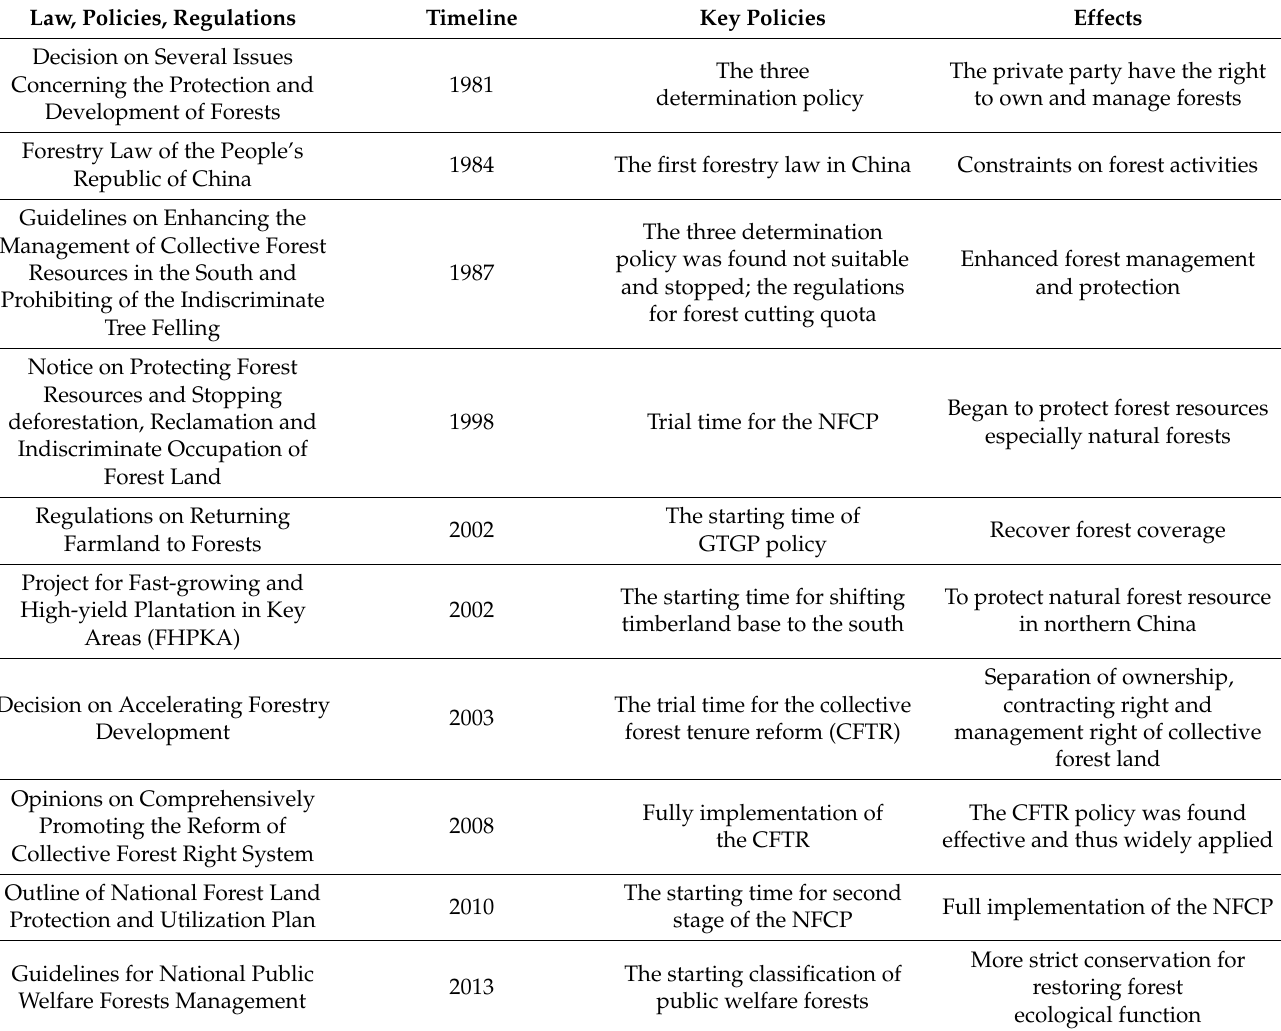
Table 2. The selected major forestry policies and regulations that affect forest loss and gain in the subtropical